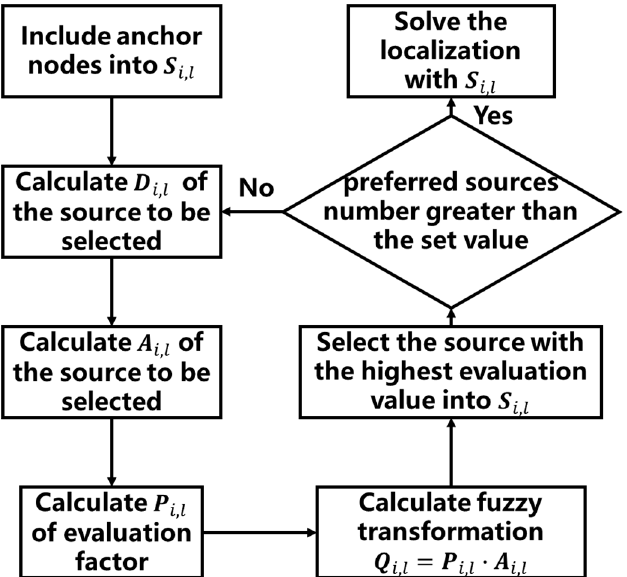
Figure 3. Flow chart of location source selection algorithm based on fuzzy comprehensive evalua- tion.